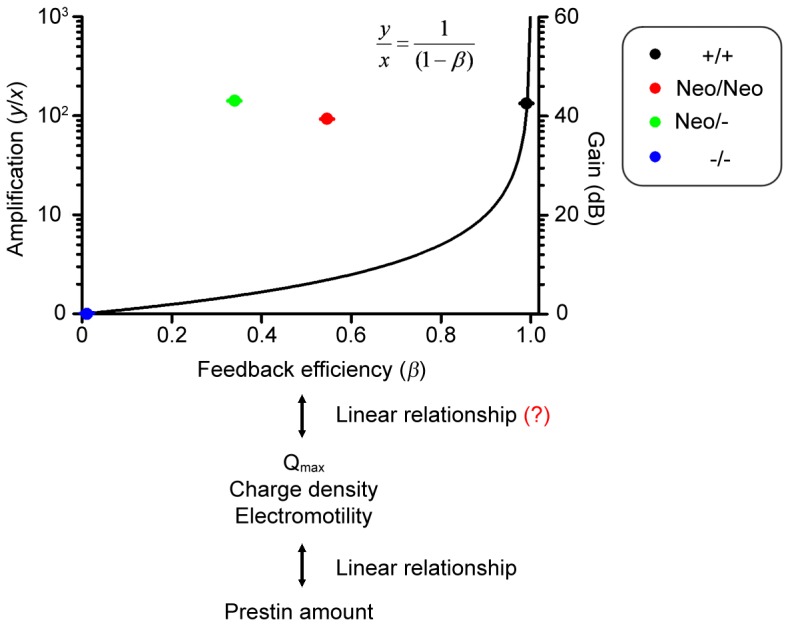
The relationship between prestin activity/feedback efficiency and amplification gain.The relationship between amplification gain and feedback efficiency proposed by Patuzzi et al. [7] is plotted as a black curve. Y-axes represent the input/output (y/x) ratio (left) and the amplification gain [dB SPL = 20log(y/x), right], respectively. The amplification gain (dB SPL) for each genotype is the ABR threshold difference between prestin −/− mice and wild-type, Neo/Neo, or Neo/- mice. Mean values derived from our data are color-coded according to genotype. In this study, averaged ABR threshold changes at 16 kHz were used to derive the amplification gain, although similar results were obtained at frequencies of 4–12 and 22 kHz. We assumed that the prestin amount was linearly correlated with Q
max, charge density or electromotility, which is further linearly correlated with feedback efficiency. Therefore, the normalized prestin activity in Neo/Neo and Neo/- OHCs by wild-type control (100% prestin activity) is expressed as the feedback efficiency (β). Values are the mean ± SEM.